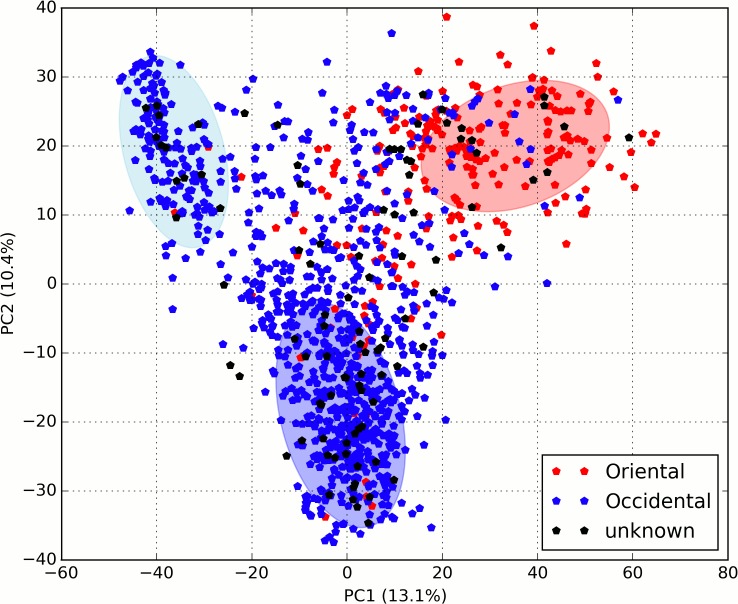
Principal component analysis of the 4,271 positively genotyped SNPs in the 1,240 unique peach accessions.Occidental and Oriental accessions are represented with blue and red colors, respectively. Black symbols indicate accessions with unknown origin.